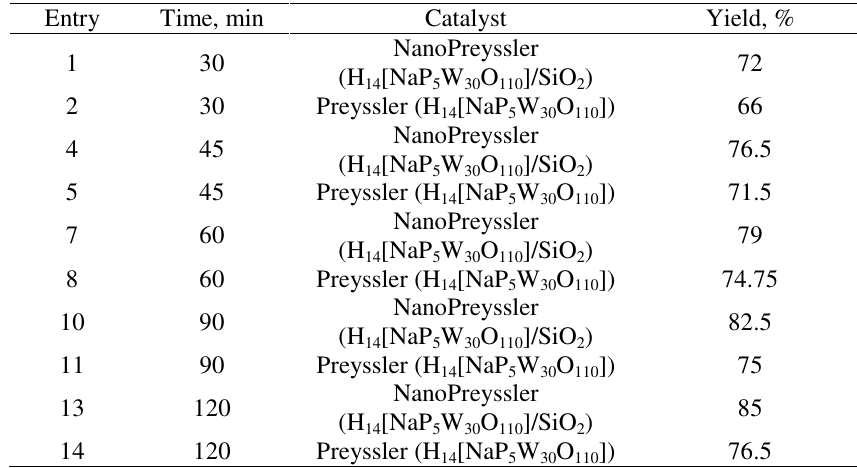
Table 1. Yields of aspirin in acetylation of salicylic acid with two different heteropolyacid catalysts at room temperature